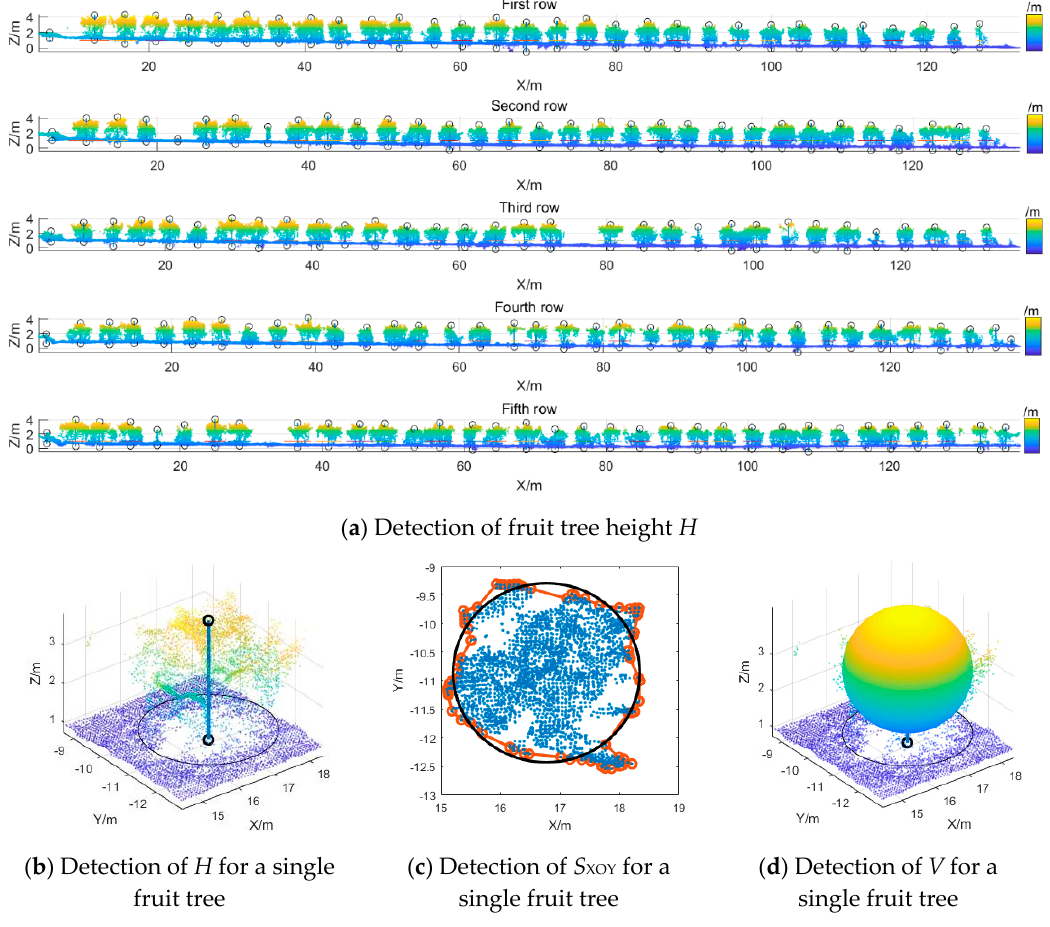
Figure 5. Detection of morphological characteristic values of orchard canopy.